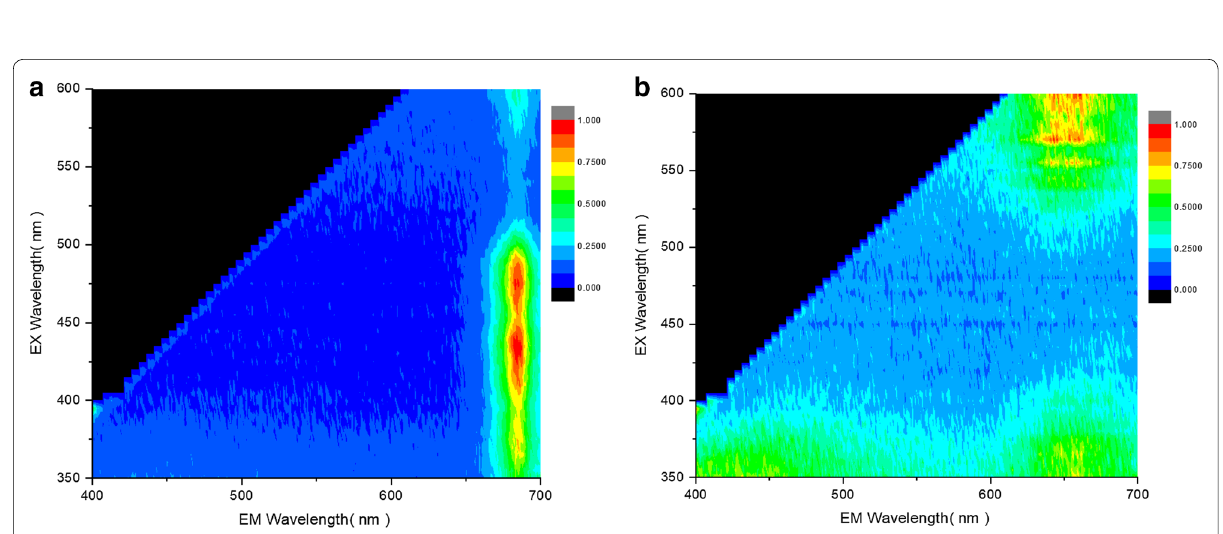
Fig. 4 Normalized fluorescence EEMs (excitation‑emission matrices) of a green algae and b blue‑green